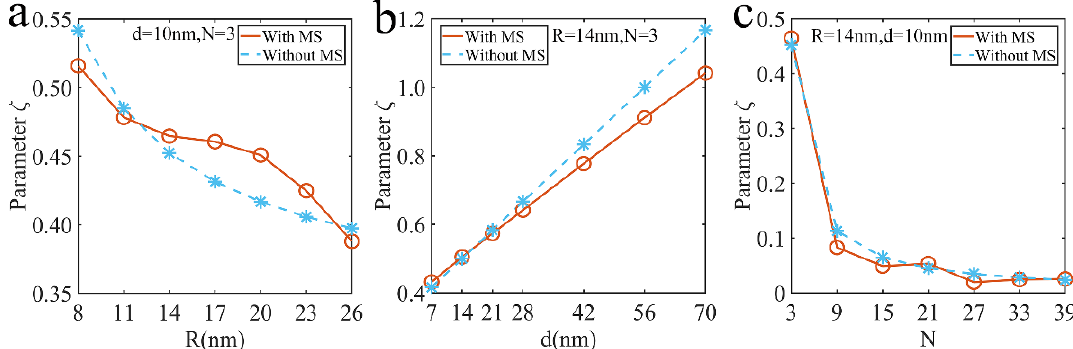
Figure 10. The relationship between the dimensionless parameter ζ and the parameter of the array structures: ( a ) radius, ( b ) particle spacing, ( c ) particle number.